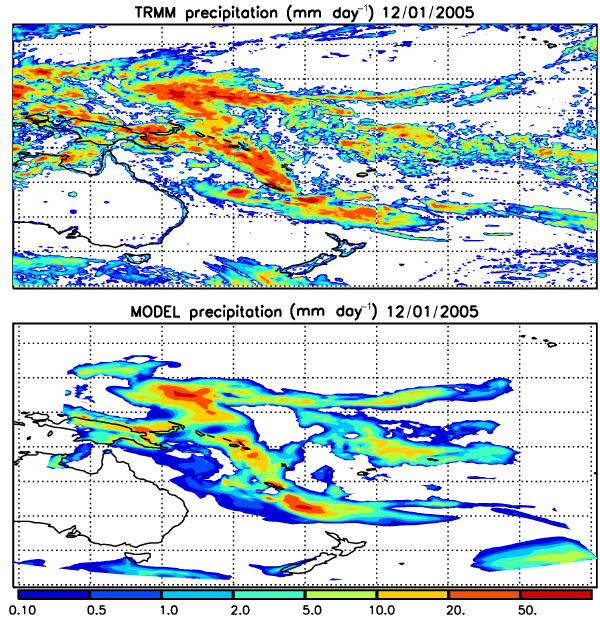
Figure 13. Daily precipitation (mmday − 1 ) for the 12 January 2005 as estimated from the TRMM satellite (3B42 product) and simu- lated by the model.